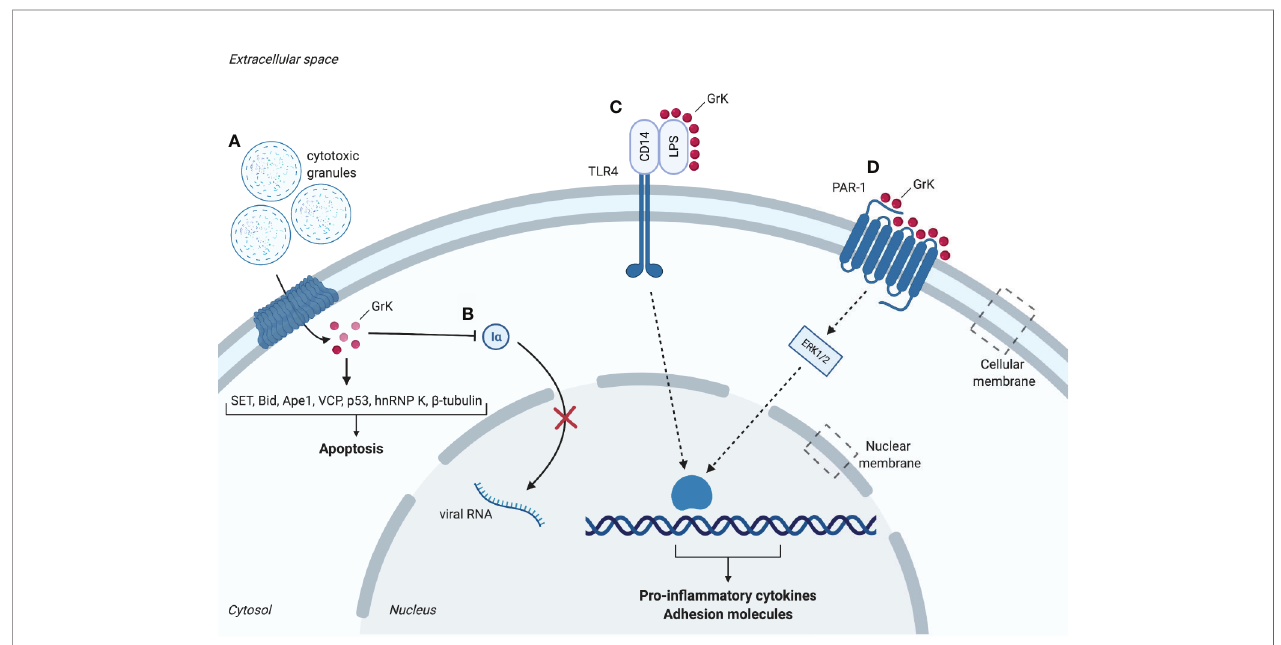
FIGURE 1 | Intracellular and extracellular substrates of granzyme K (GrK). (A) Cytotoxic granules containing perforin and granzymes enter the cell. GrK binds or cleaves substrates SET, Bid, Ape1, VCP, p53, hnRNP K and b -tubulin which promote apoptosis. (B) GrK inhibits replication of in fl uenza A through cleavage of importin-1 a and - b , thereby hindering nuclear uptake of importin-1 a and - b . (C) GrK cleaves and activates PAR-1. Downstream phosphorylation of ERK1/2 results in a pro-in fl ammatory cytokine response (e.g. IL- 1 b , MCP-1, IL-6, IL-8) and increased expression of adhesion molecules (e.g. ICAM-1, VCAM-1, E-selectin). (D) GrK facilitates binding between LPS and CD14. CD14 binds to TLR4 which leads to a pro-in fl ammatory cytokine response. I a , importin-1 a ; LPS, lipopolysaccharides; PAR-1, Protease-activated receptor 1; TLR4, Toll-like receptor 4. Red spheres: granzyme K. Figure created with